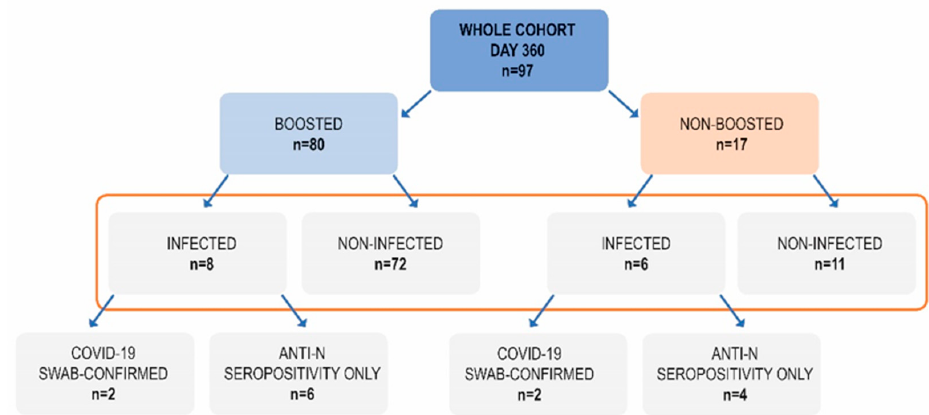
Figure 3. The composition of subgroups based on the booster administration and SARS-CoV-2 infection between days 240 and 360.